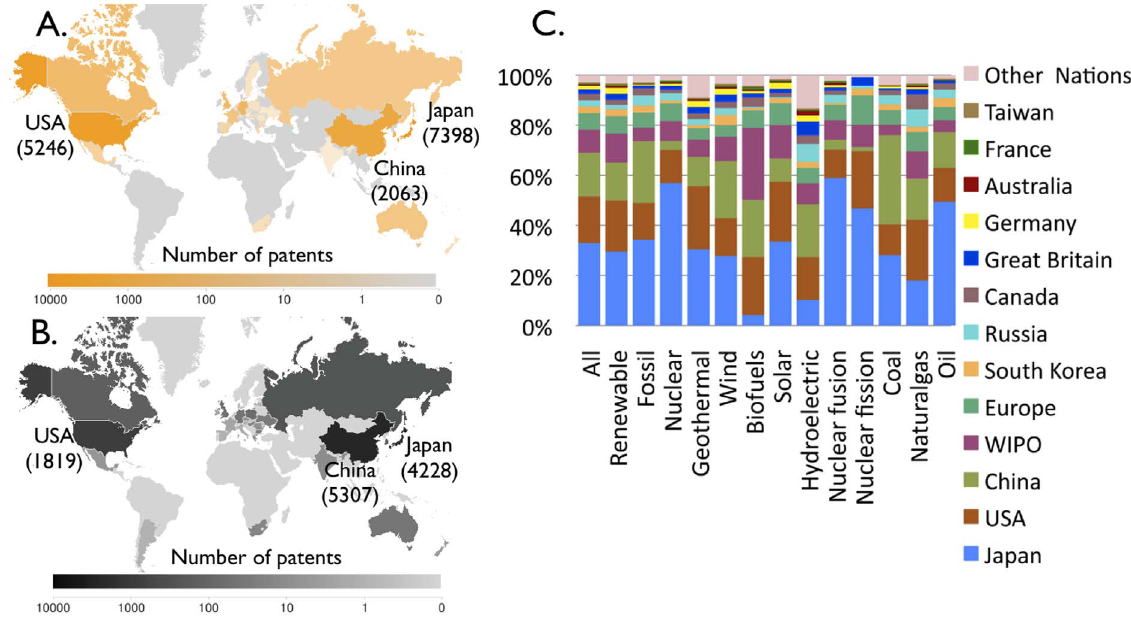
Figure 2. Regional patterns in energy patents. (A.) World map of cumulative patents in photovoltaics (solar). Japan is the leading nation in terms of patent numbers, followed by the US and China (patent numbers through 2009 are shown in brackets). In addition there are 1951 patents in the European Union (EPO) and 2882 worldwide (not shown). (Patents in wind technologies are distributed similarly and therefore not shown. Japan is again the leading nation, followed by China and the US. There are also 702 patents in the European Union and 1484 worldwide.) (B.) World map of patents in coal-based electricity. China is the leading nation, followed by Japan, and the US. There are 887 patents filed in the European Union and 620 worldwide. (C.) Cumulative patents submitted by technology and nation indicate the dominance in terms of patent counts of certain countries, and also differences across countries in the relative importance placed on each technology.